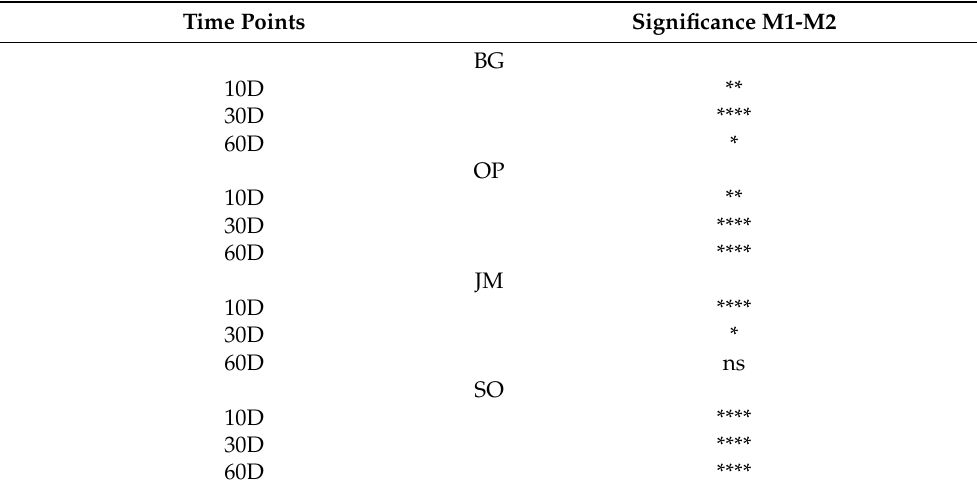
Figure 8. Statistical analysis of the histomorphometrical results of the immune response within the implantation bed of the analyzed barrier membranes (Ossix ® Plus (red), Bio-Gide ® (blue), Jason ® membrane (green)) and of the sham operation (black). Vertical stripes: CD11c and horizontal stripes: CD163. (* p ≤ 0.05, ** p ≤ 0.01, **** p ≤ 0.0001). Table 2. Interindividual statistical differences between the M1 and M2 cell numbers within the implantation beds of the analyzed barrier membranes (Ossix ® Plus (OP), Bio-gide ® (BG), Jason ® membrane (JM) and the sham operation (SO) (* p ≤ 0.05, ** p ≤ 0.01, **** p ≤ 0.0001, ns: not